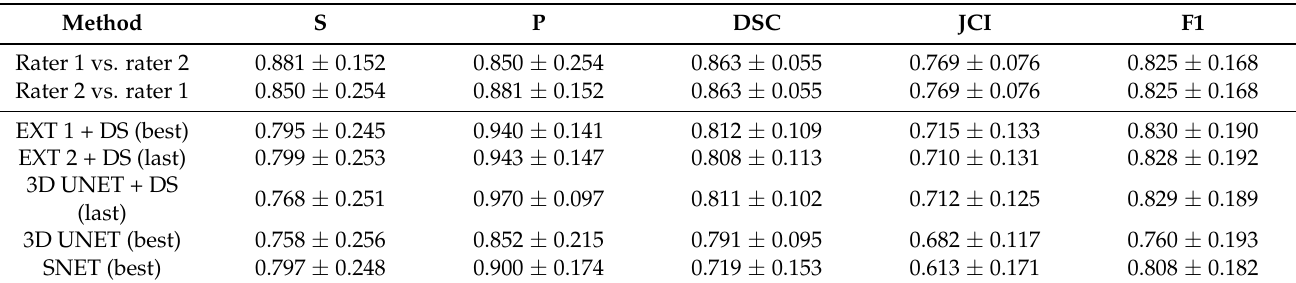
Table 3. Effectiveness of the proposed follicle detection methods compared to the state-of-the-art and inter-rater variability. Presented are the mean and Standard Deviation of Sensitivity or Recall (S), Precision (P), Dice Similarity Coefficient (DSC), Jaccard Index (JCI), and the F1 score (F1) on the USOVA3D